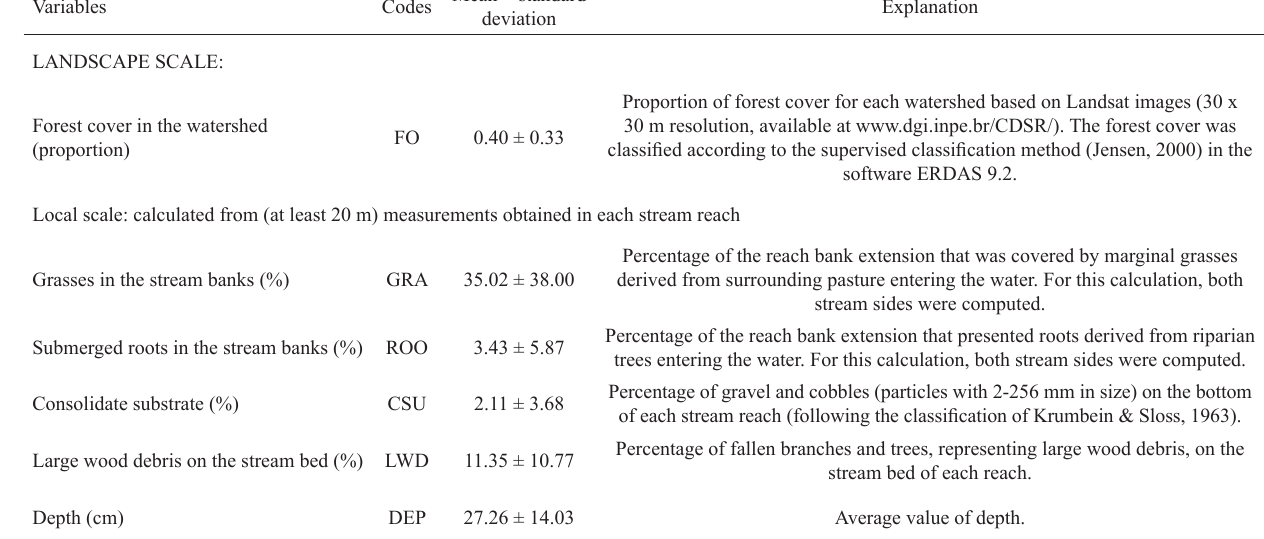
Table 1. Scales, variables, codes, mean ± standard deviation, and explanation of how each variable was obtained.